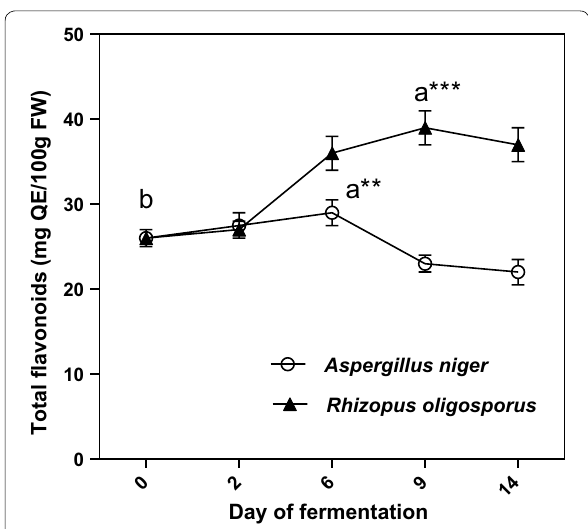
Fig. 2 Total flavonoids in extracts from solid state fermented apricot pomaces. Values are mean SD of triplicate determinations and ± different letters (a, b) indicate significant differences (p < 0.05) (paired